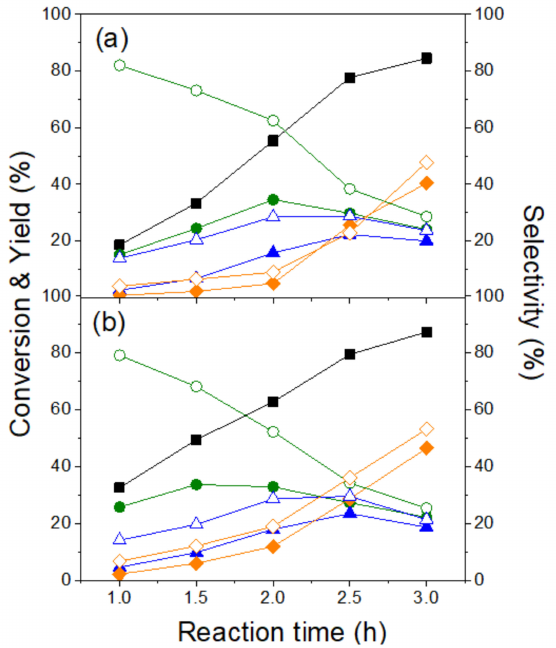
Figure 4. The influence of the reaction time on the etherification reaction of glycerol in the presence of ( a ) NaOAc and ( b ) KOAc with NaHSO 4 and KHSO 4 , respectively (- (cid:4) -: conversion of glycerol, - • -: yield of DG, - (cid:78) -: yield of TG, - (cid:7) -: yield of others - -: selectivity of DG, - ∆ -: selectivity of TG, - ♦ -: (cid:35) selectivity of others, the amount of catalyst: 0.5 mol%, the amount of additive: 0.37 mol% and the reaction temperature: 280 ◦